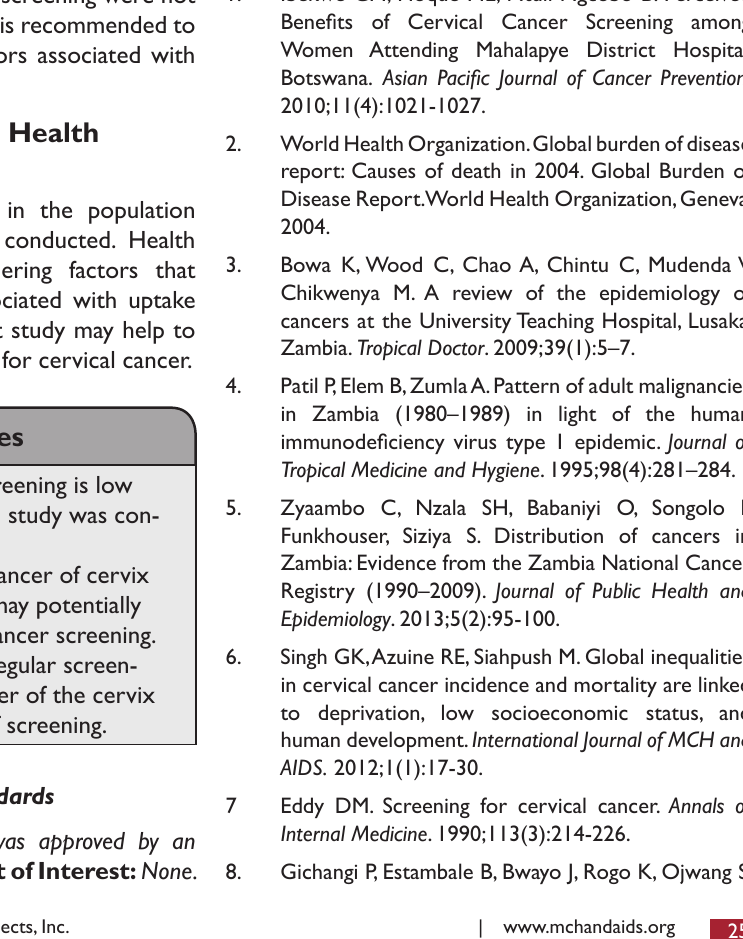
Figure 3 : Independent factors associated with cervical cancer screening could have been associated with screening were